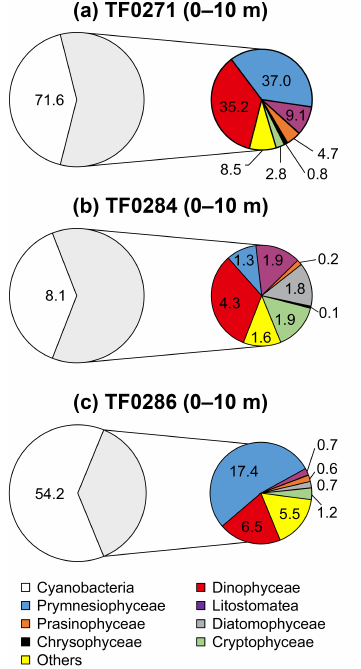
Figure 8. Surface phytoplankton community composition inte- grated over the upper 10m of the water column (mgCm − 3 ) at sta- tions with a distinct (a) and without a distinct (b, c) subthermocline methane enrichment. The grey shaded non-cyanobacteria commu- nity is described in detail in the coloured